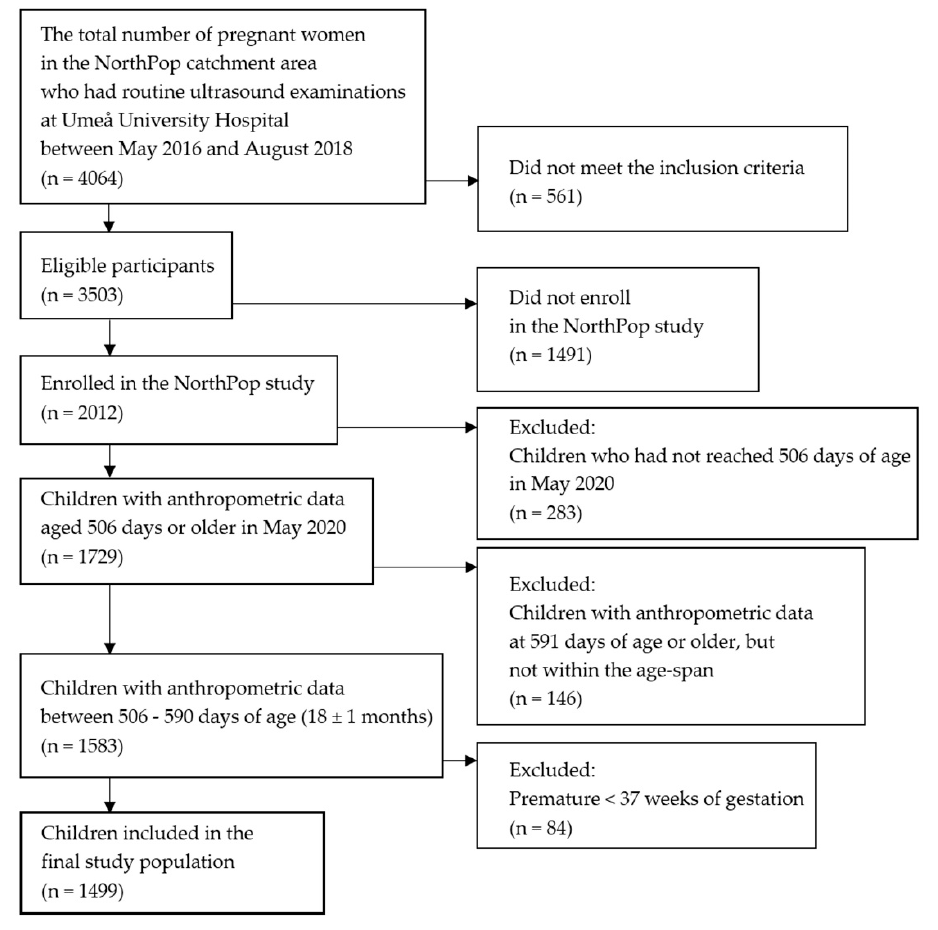
Figure 1. Flow chart illustrating the study population.